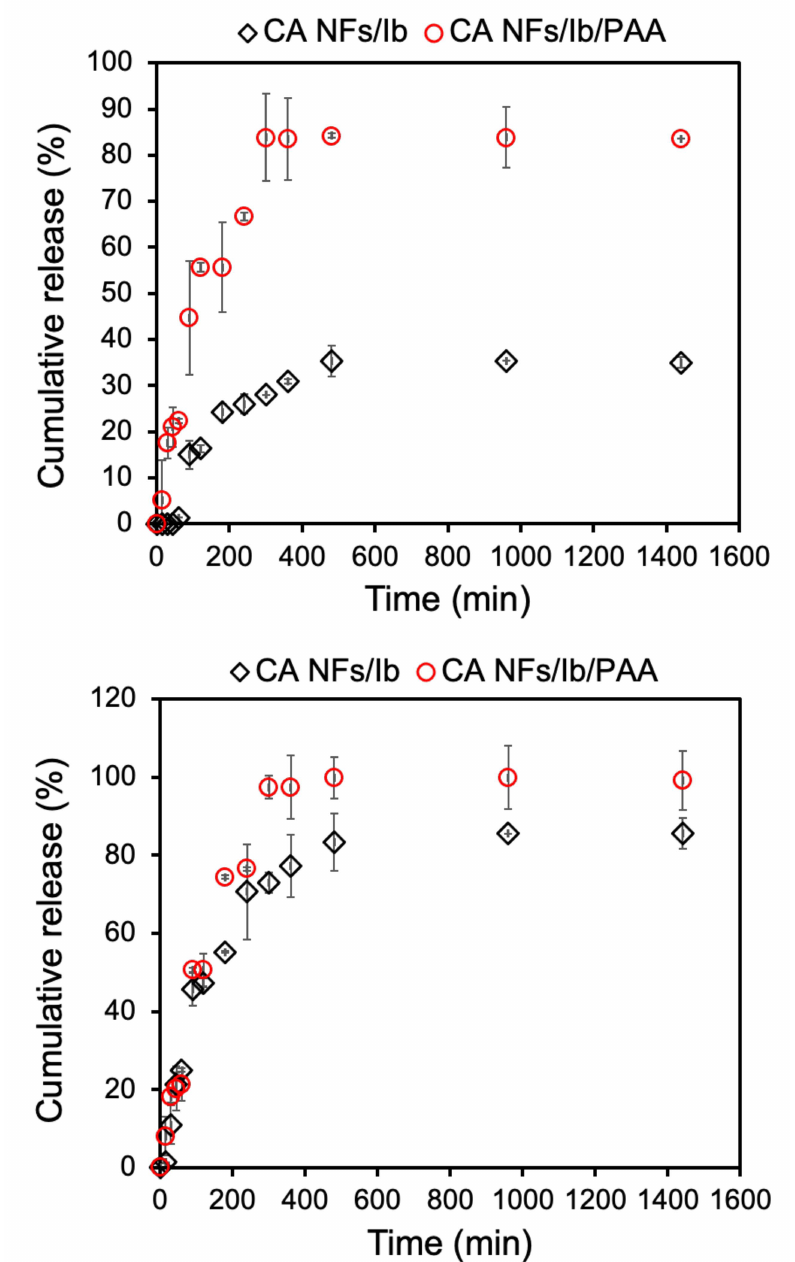
Figure 5. Time independent drug release profile of both non-coated and poly-AAm coated CANFs. ( Top ): 5 wt.% Ib-loaded CANFs; ( Bottom ): 10 wt.% Ib-loaded CANFs (bottom) (Black diamonds: uncoated, red circles: poly-AAm coated). Measurements have been done in